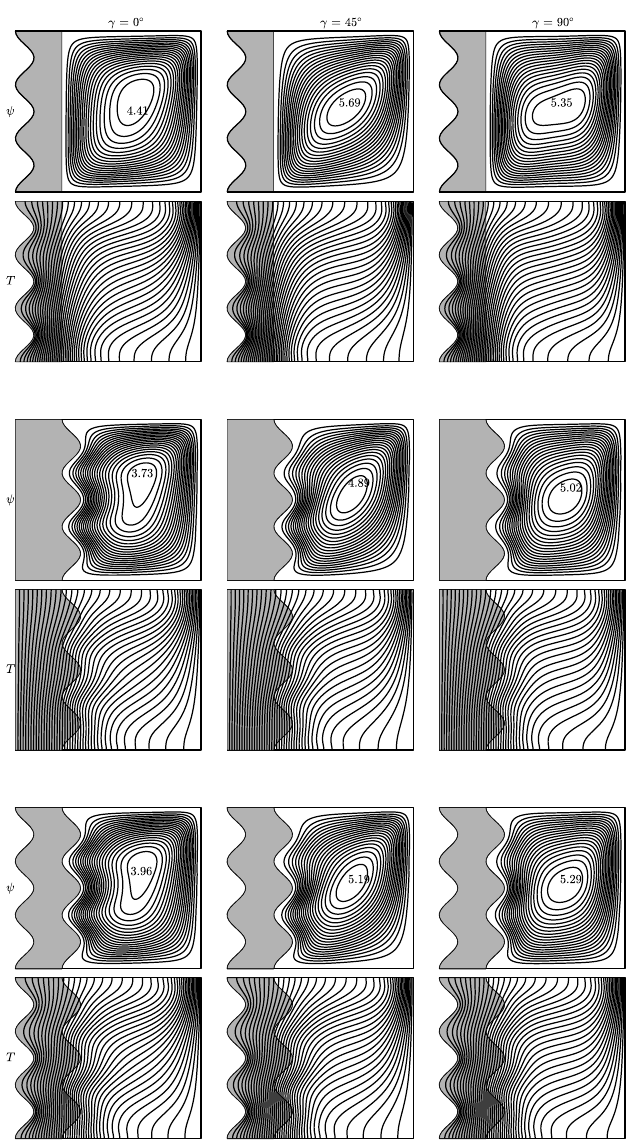
Figure 9. Variation in γ when Ra = 10 5 , Ha = 25, kr = 1, A = 0.05, n = 3. Streamlines and isotherms at the ( top ) is for case 1, at the ( middle ) is for case 2 and the at ( bottom ) is for case